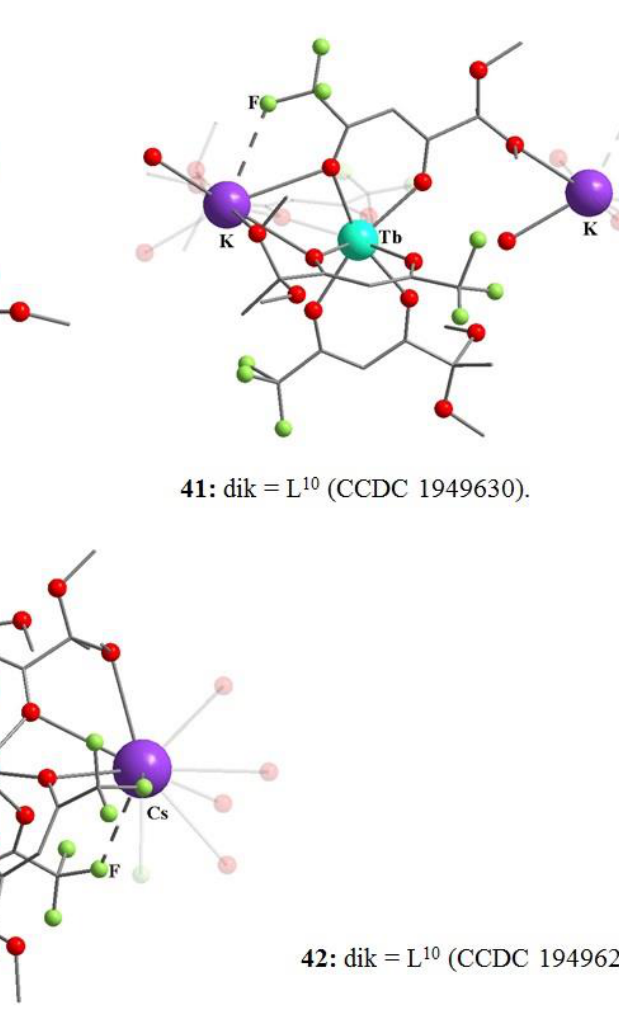
Figure 21. Molecular structures of 40 – 42 [62]. Hydrogen atoms have been omitted, some CF 3 groups are transparent for clarity. The cif has been retrieved from CCDC.